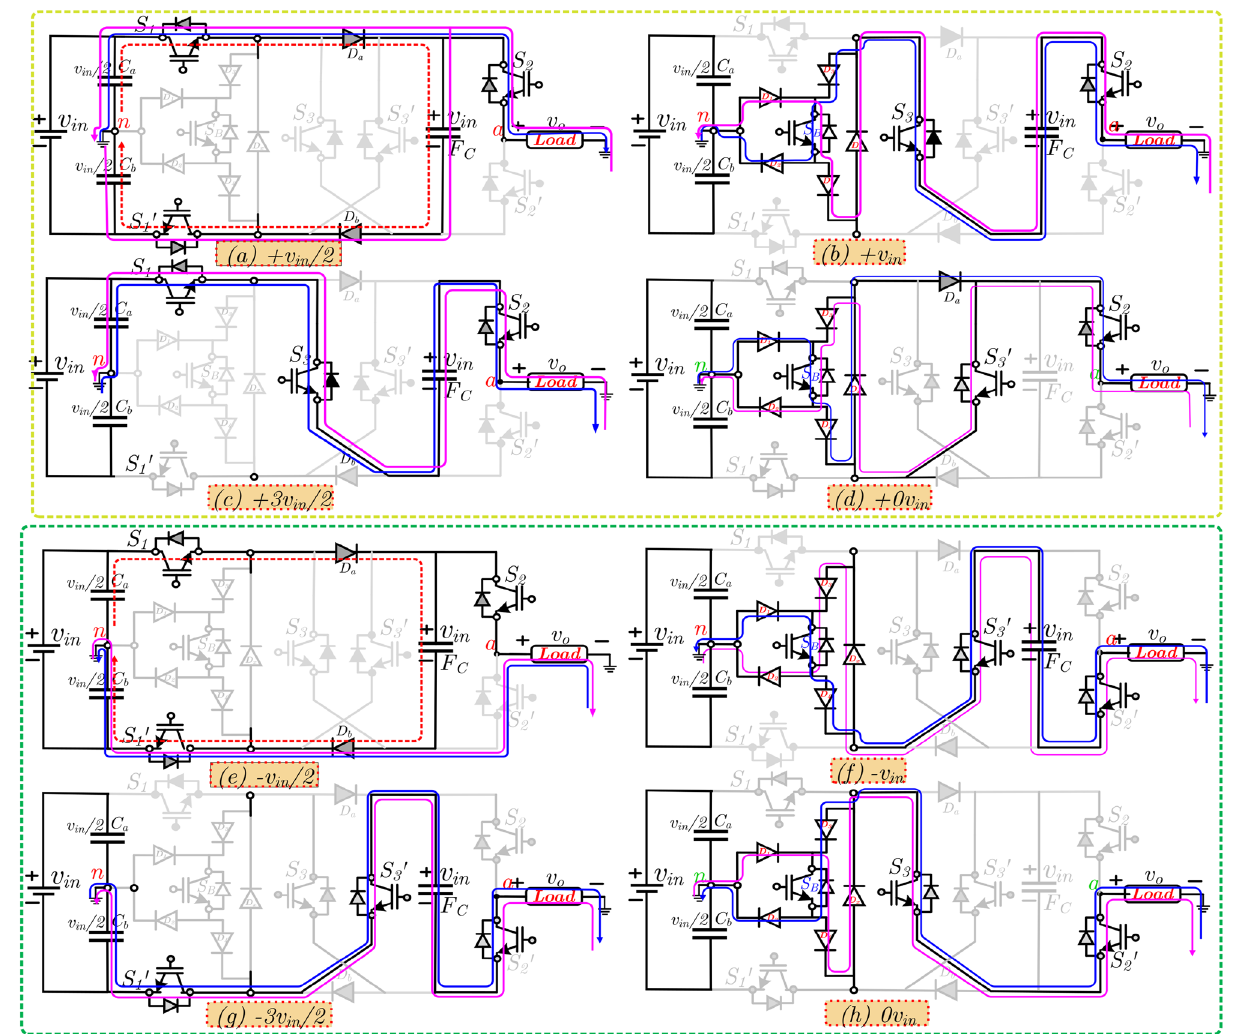
Figure 3. Modes of operation of proposed 7L ANPC inverter topology ( a – d ) positive half cycle and ( e – h ) negative half